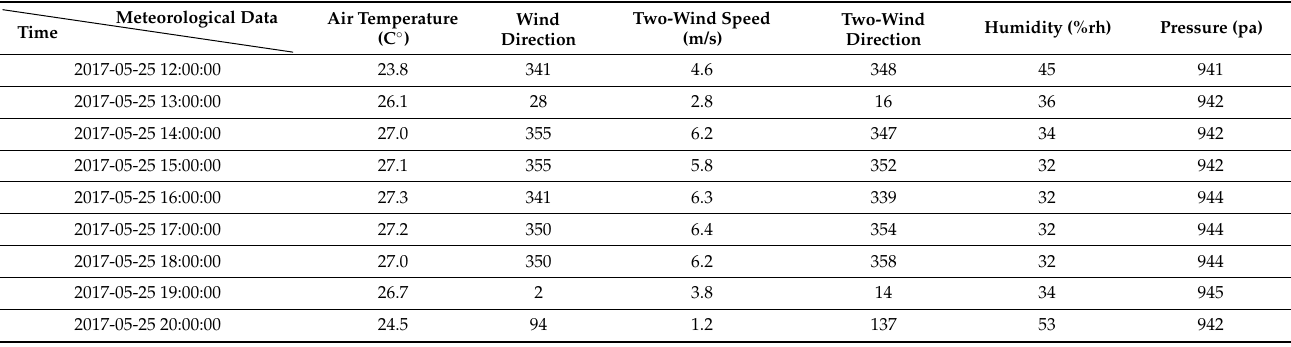
Table 1. Partial meteorological